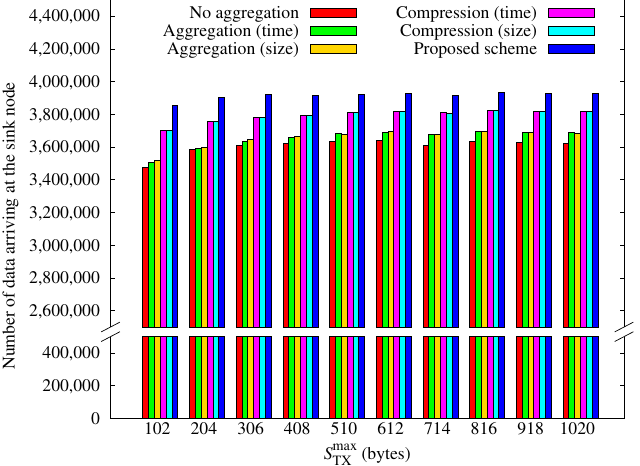
Figure 13. Comparison of the amount of data obtained according to the maximum transmission